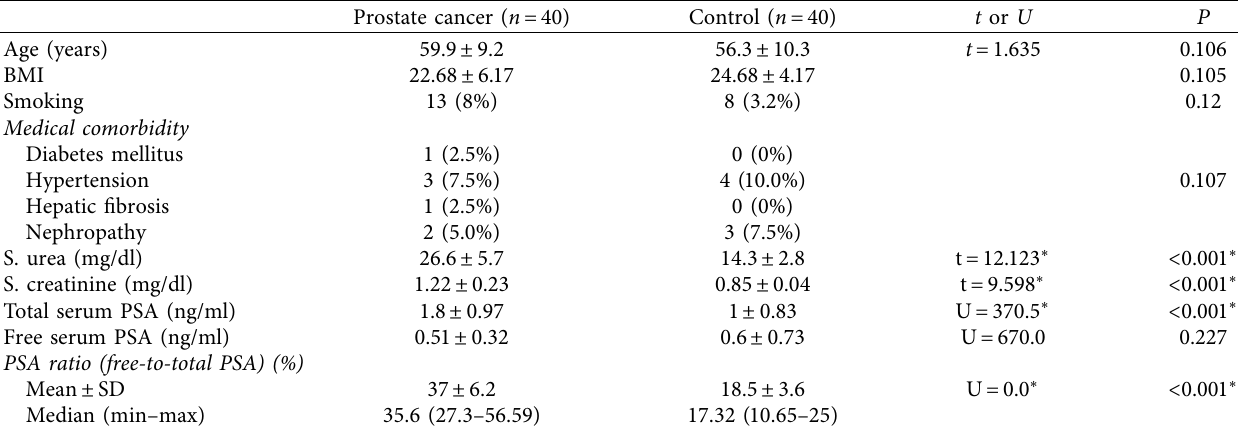
Table 1: Patients’